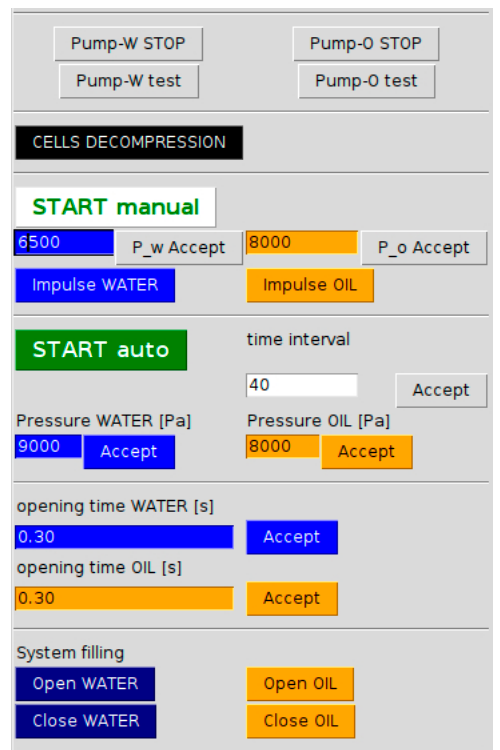
Figure A1. Graphical user interface (GUI) of the software developed for control over the parameters of single droplet generation.